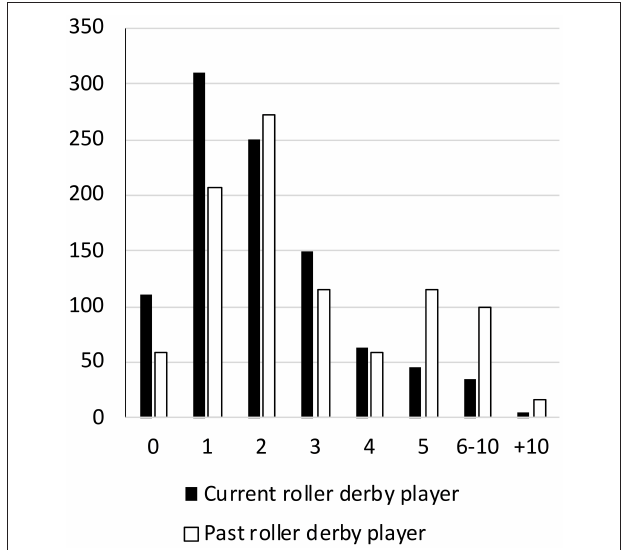
FIGURE 3 | Number of concussions per player during roller derby per 1,000 athletes.